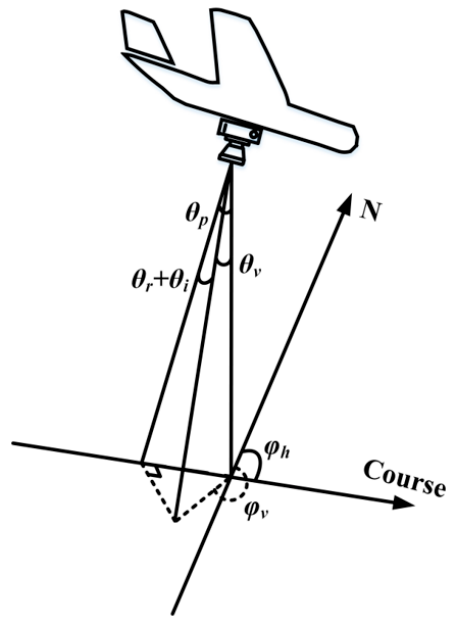
Figure 3. View zenith angle and view azimuth angle. According to the assumption of radiation uniformity, the mean ground radiance of each column is equal. Equation (8) represents that the mean ground radiance of the scanning center point was equal to that of other columns.